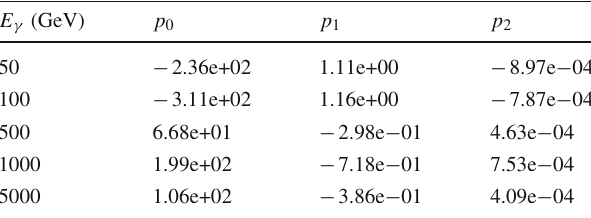
Table 2 Best fit parameters for the function r 50 ( X sl ) = p 0 + p 1 X sl +